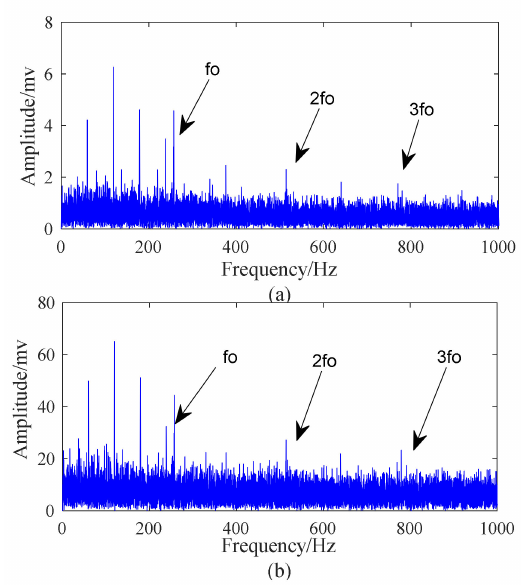
Figure 23. The diagnosis result obtained by IMF4 of the collected signal of the bearing with 1 mm outer race fault: ( a ) the squared envelope spectrum of IMF4; ( b ) the teager energy spectrum of